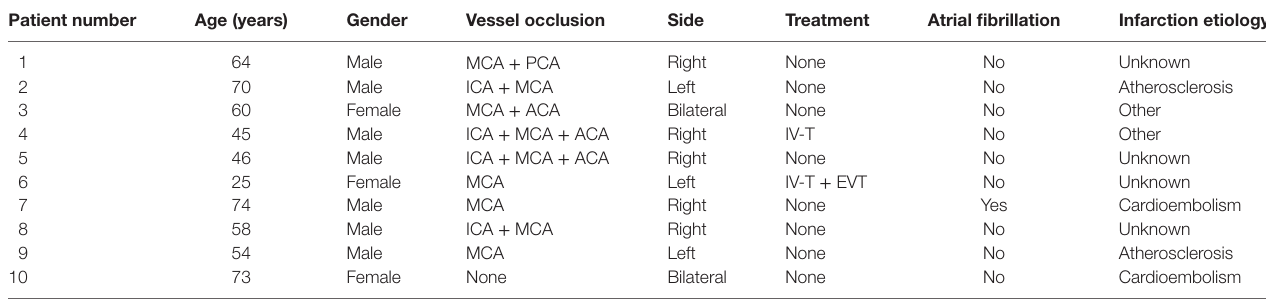
TaBle 1 | Patients’ characteristics.